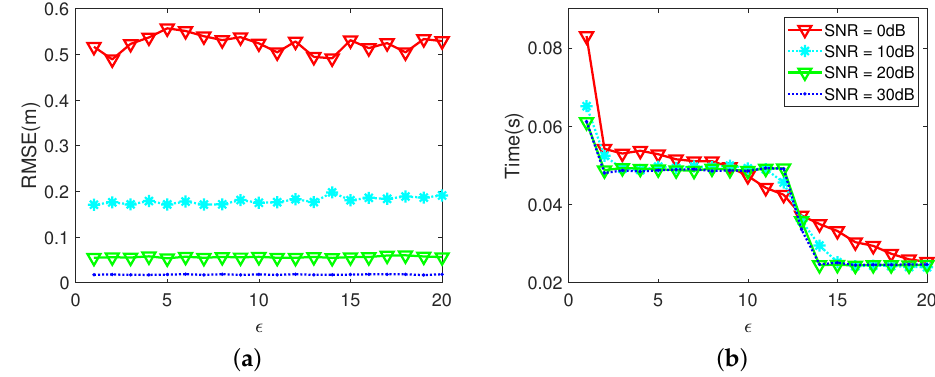
Figure 19. Performance of Tomo-ANM-IVDST under different shrinkage-threshold (cid:101) and SNRs. ( a ) Location accuracy. The legend is the same as in ( b ). ( b ) Time